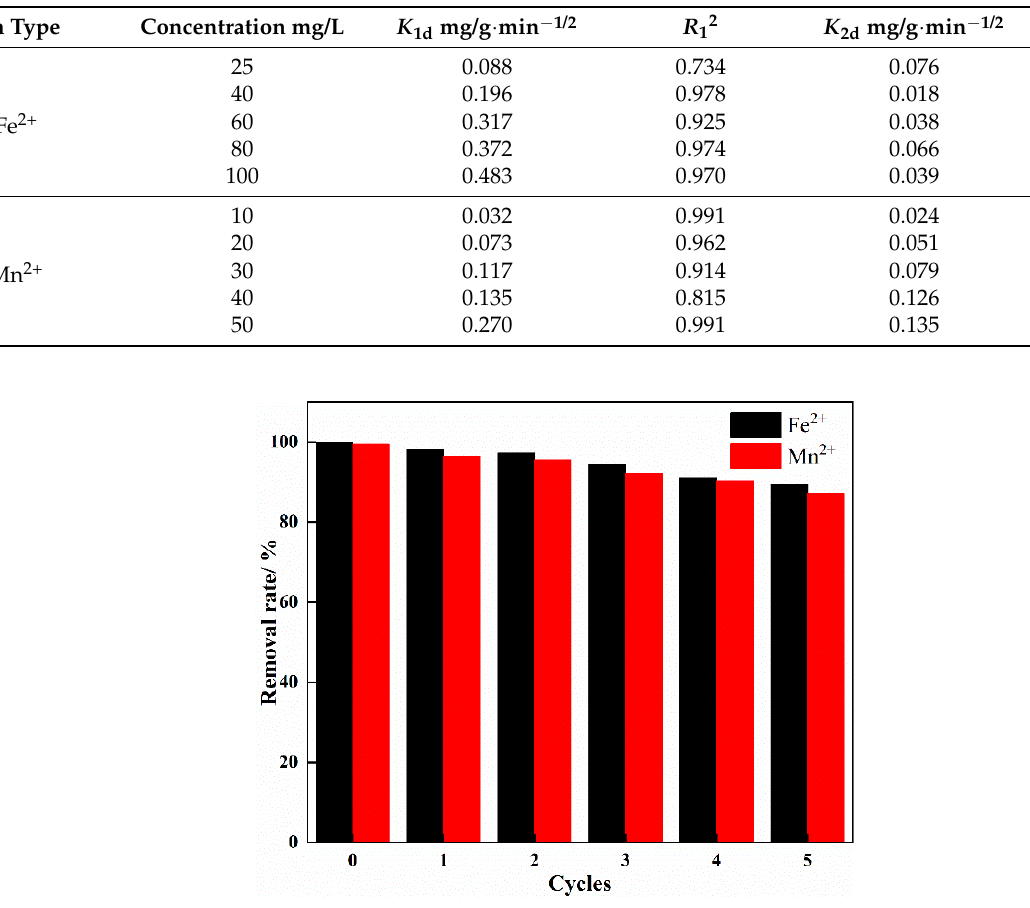
Figure 7. Fitting curve of the internal diffusion equation of Fe 2+ ( a ) and Mn 2+ ( b ). Table 4. Internal diffusion model fitting results.